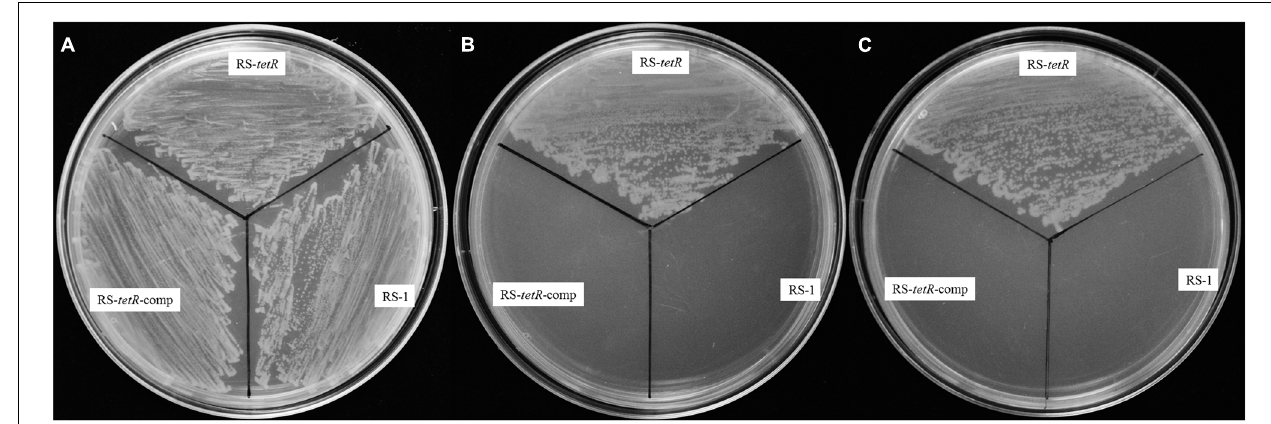
FIGURE 2 | Survival assays of RS-1, RS- tetR and RS- tetR -comp, respectively. The mutant strain grew well on the LB plates containing paraquat or H 2 O 2 , while the growth of wild-type and complementary